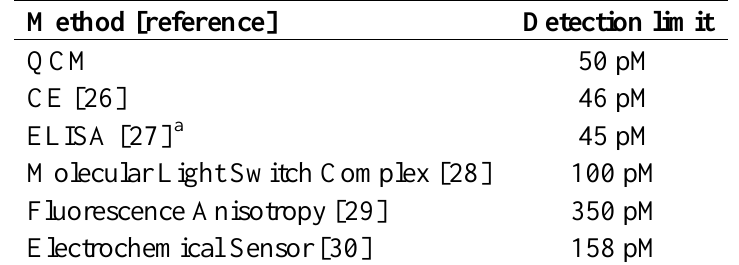
Table 1. Summary of the IgE determination limit obtained by various